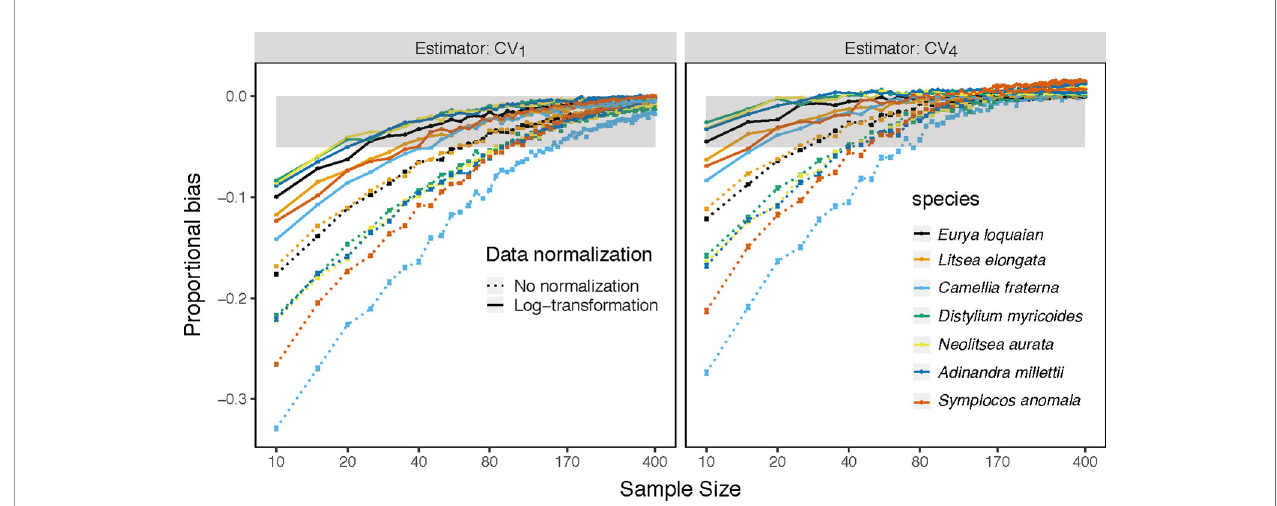
FIGURE 3 | Mean proportion of bias of the CV 1 and the best estimator CV 4 on sample size k ( k ∈ {10,15,20, … 400}) for speci fi c leaf area of each species (colored line) with abundance ≥ 400 based on the raw (dotted line) and log-transform (solid line) trait values in Tiantong tree data. Gray area is the region in which the absolute mean proportion of bias is less than 0.05.